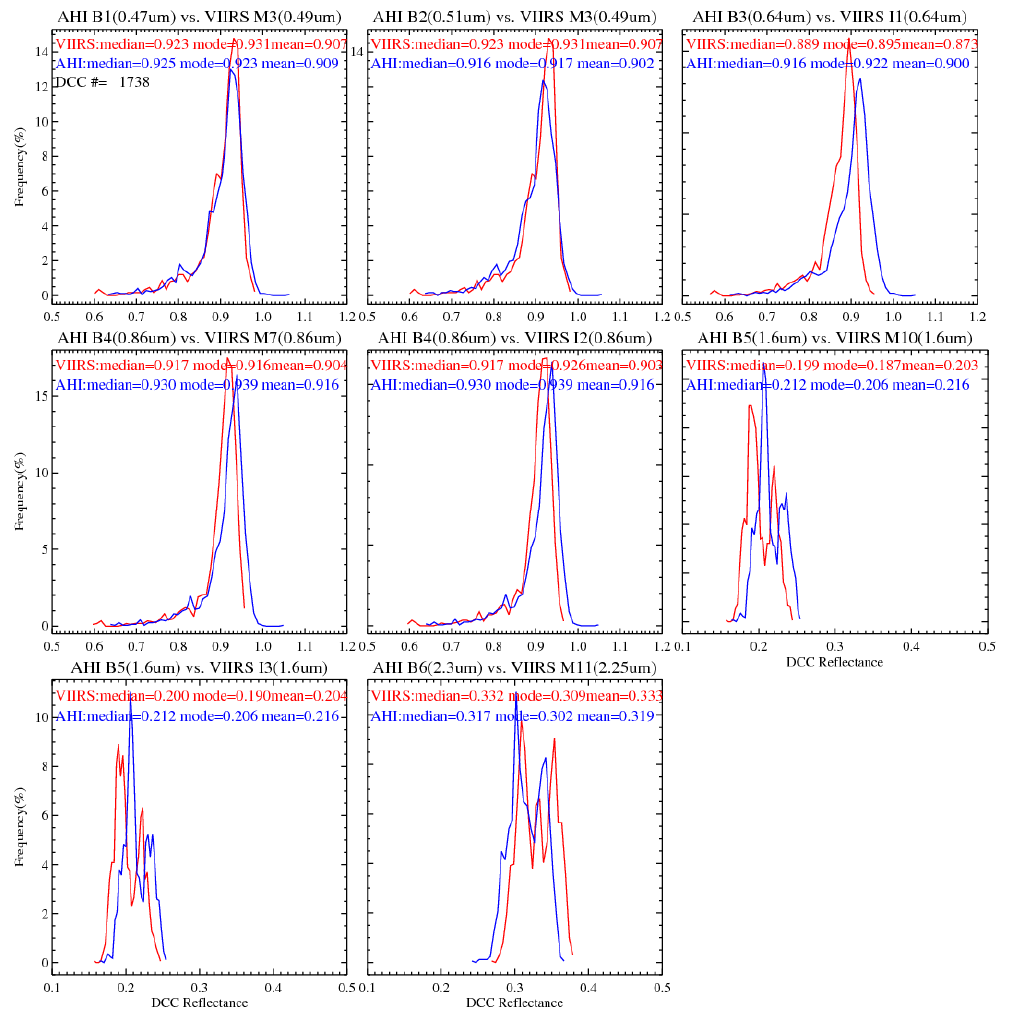
Figure 7. Histograms of collocated DCC reflectance for the data collected from 20 July to 20 August 2015, All the bands have the same DCC pixels. The y-axis is the DCC frequency (%) and the x-axis is the DCC reflectance. the DCC